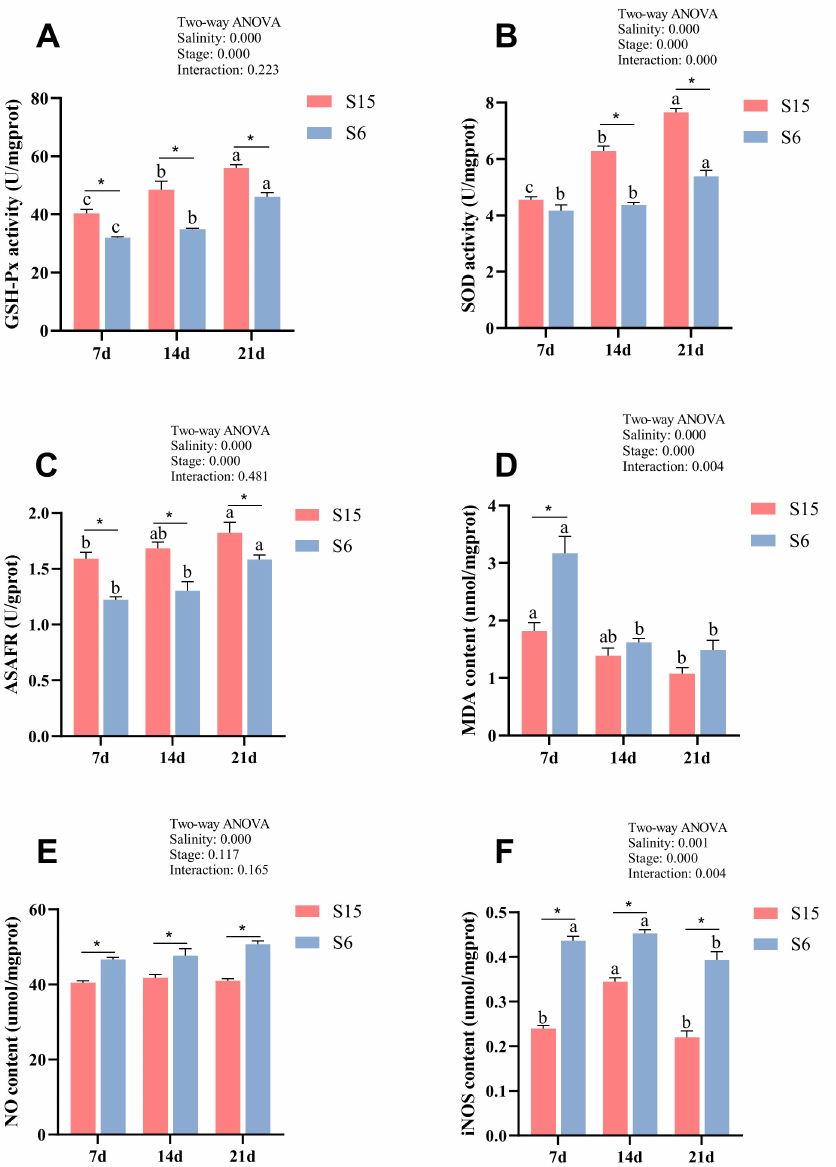
Figure 1. Combined effect of salinity and different development stages on Glutathione peroxi- dase ( A , GSH-Px); superoxide dismutase ( B , SOD); anti-superoxide anion free radical compound ( C , ASAFR); malondialdehyde ( D , MDA); nitric oxide ( E , NO); inducible nitric oxide synthase ( F , iNOS) of Macrobrachium rosenbergii post-larvae. Note: Data are mean values of nine replicates expressed as mean ± SE. “a, b, c” showed significant differences ( p < 0.05) in the same group between different development stages. “*” showed significant differences ( p < 0.05) between different salinity under the same development